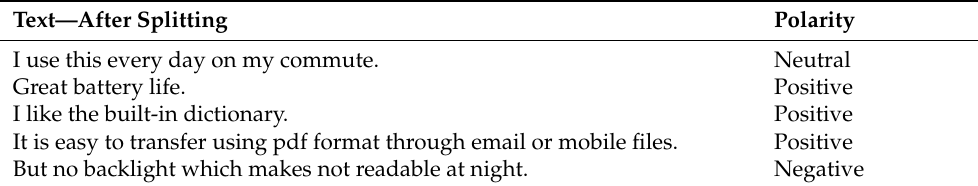
Table 2. Example sentence after splitting using punctuation and sentiment-analysis information. Text—After Splitting Polarity